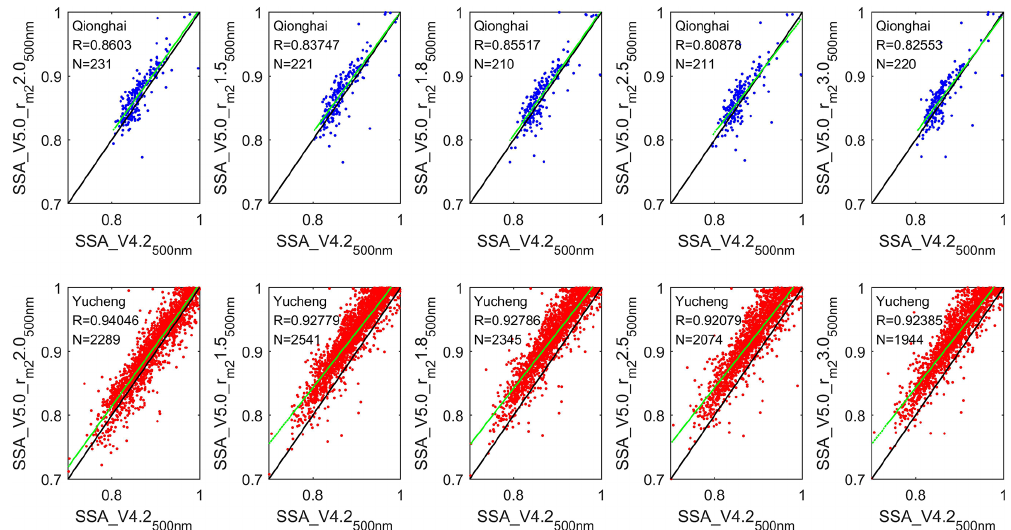
Figure 9. Scattergrams of retrieved SSA by SKYRAD V4.2 and V5.0 when r m 2 = 2 . 0 (default), 1.5, 1.8, 2.5, and 3.0 for Qionghai (a) and Yucheng (b) in 2014. r m 2 represents the model radius for the coarse-mode SDF.